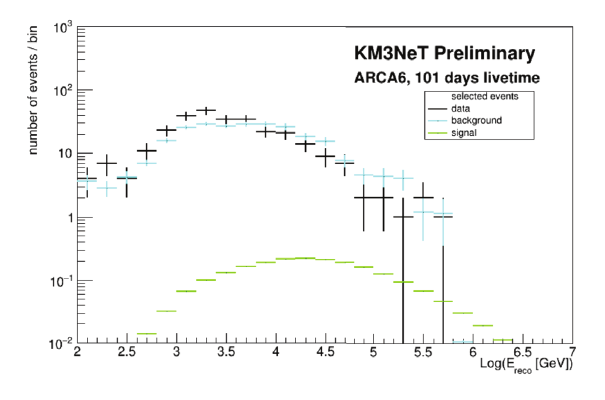
Figure 6: Energy distribution of selected data events (black points). The superimposed energy distributions of atmospheric background (light blue points) and of cosmic neutrino events (green points) estimated from MonteCarlo simulations are also